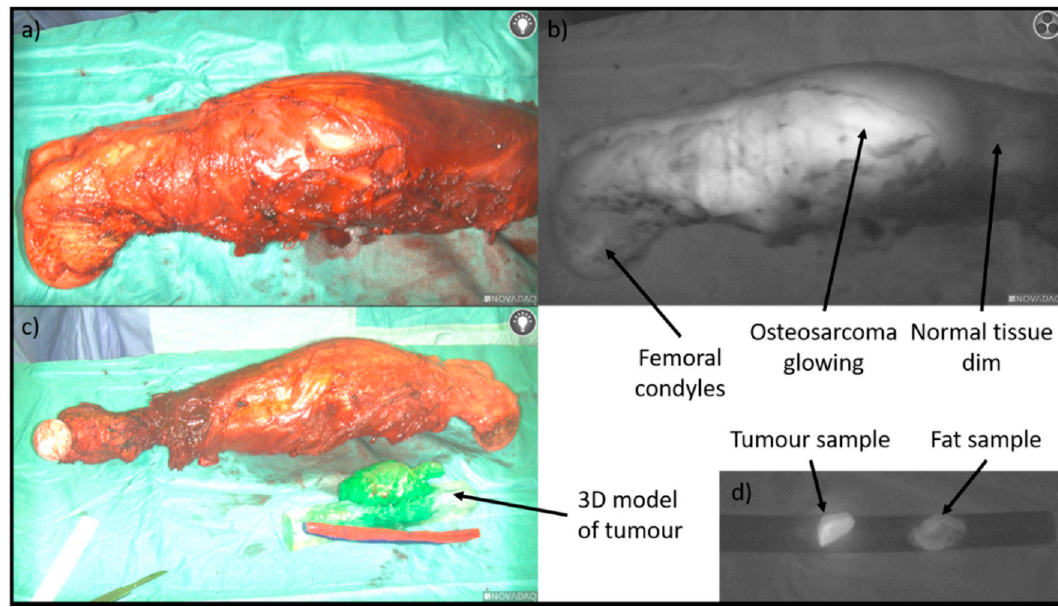
Figure 2. ( a ) Shows the resected femur and OS contained within vastus medialis. ( b ) Shows the specimen through the infrared camera (Stryker), with the OS glowing bright. ( c ) Shows the resected specimen next to the three-dimensional (3D) printed model produced prior to the procedure (Axial3D). ( d ) A sample of the tumour was dissected out of the specimen to demonstrate higher fluorescence compared to a piece of